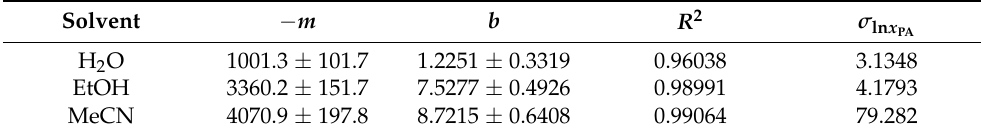
Table 3. Parameters for equation (2) and coefficients ( R 2 ) in the calculation of ln x PA .